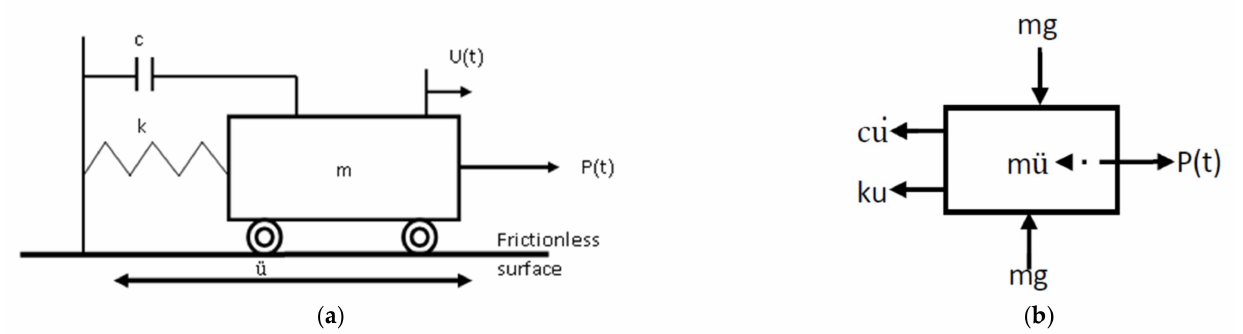
Figure 3. The shaking table setup and main components. ( a ) The shaking table assembly. ( b ) The designed and fabricated soil rigid box/container.